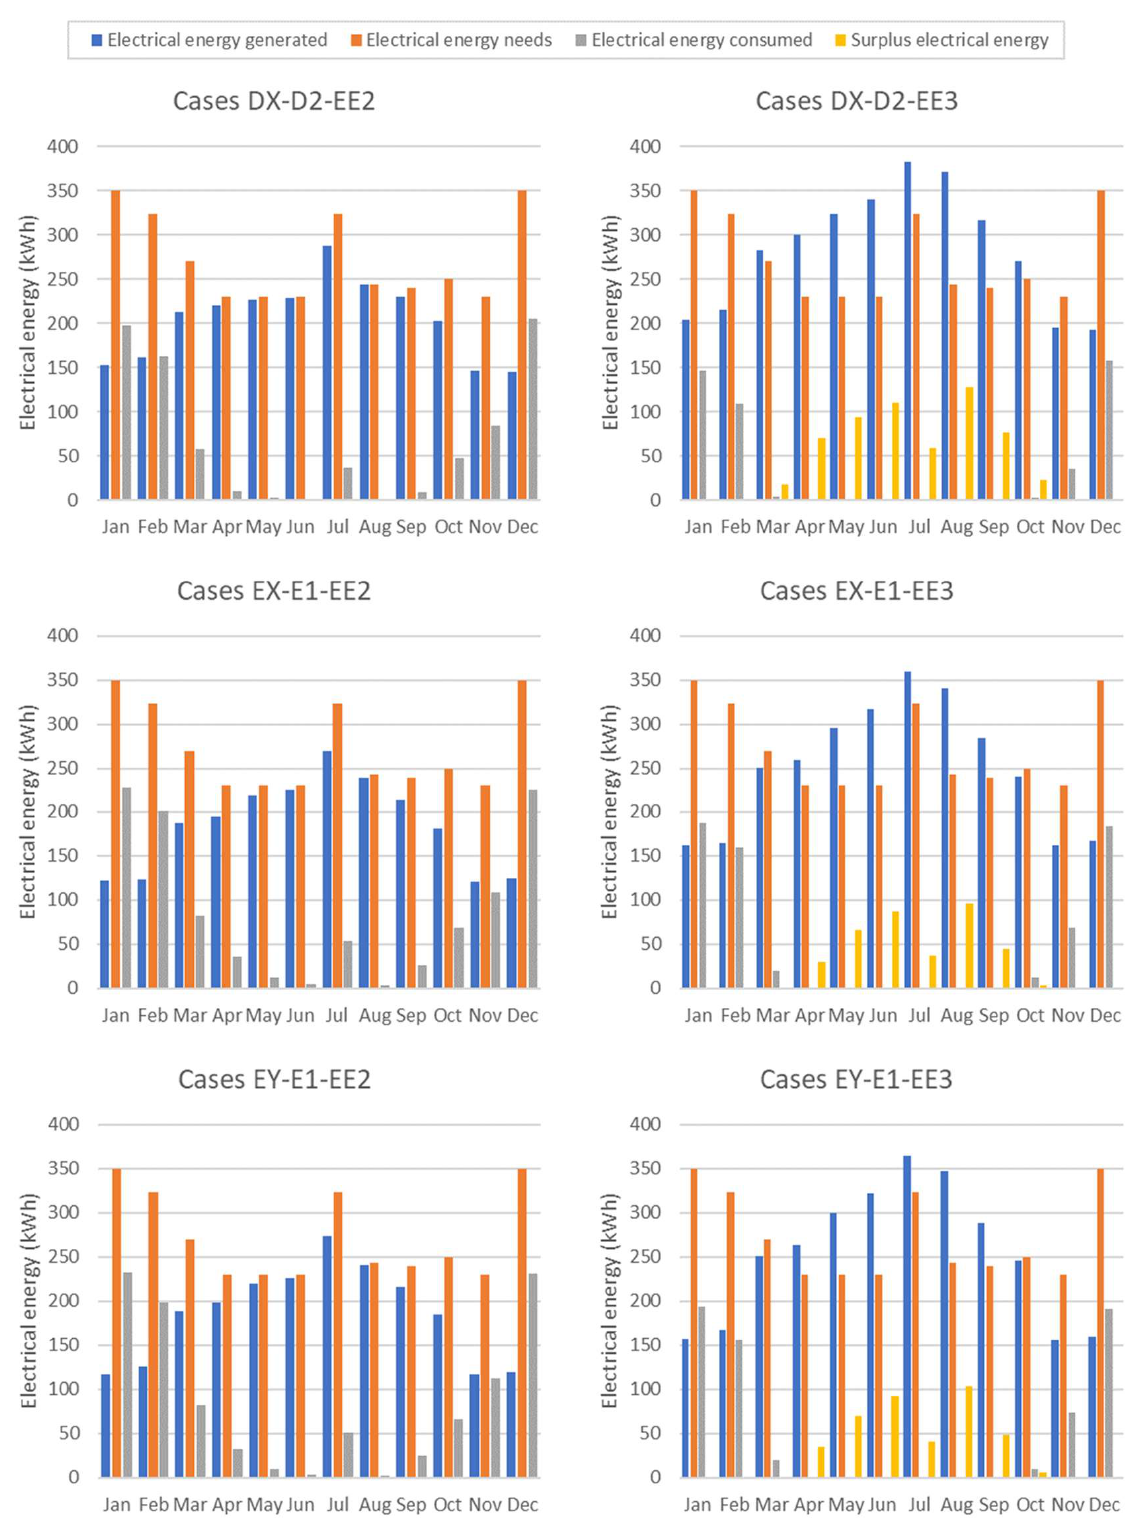
Figure A2. Monthly electrical energy balances for cases EE2 and EE3 in the different CCZs. Table A2. Verification of compliance with the CTE-DB-HE [52] for each case study in Cervera del Río Alhama (CCZ DX-D2).